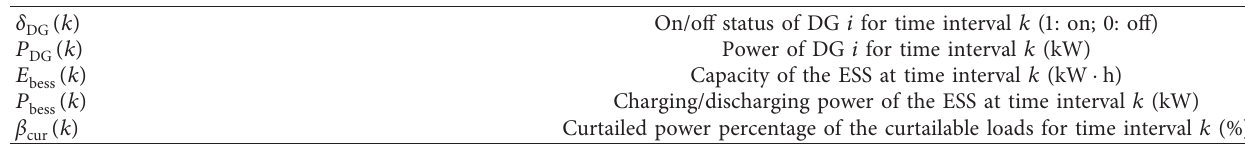
Table 3: Decision